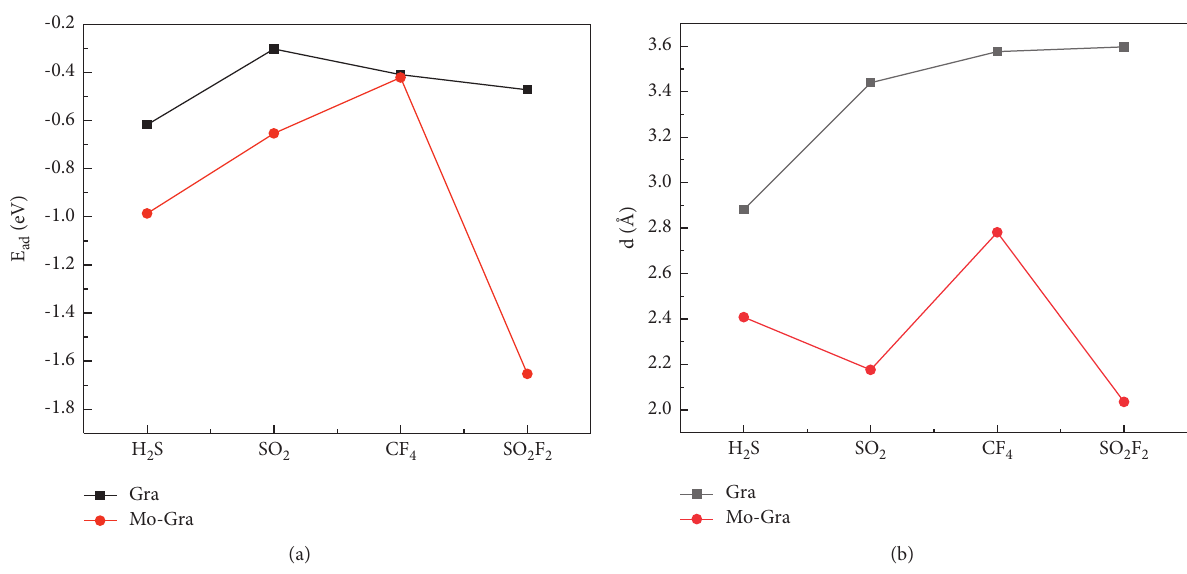
Figure 6: Adsorption properties of H